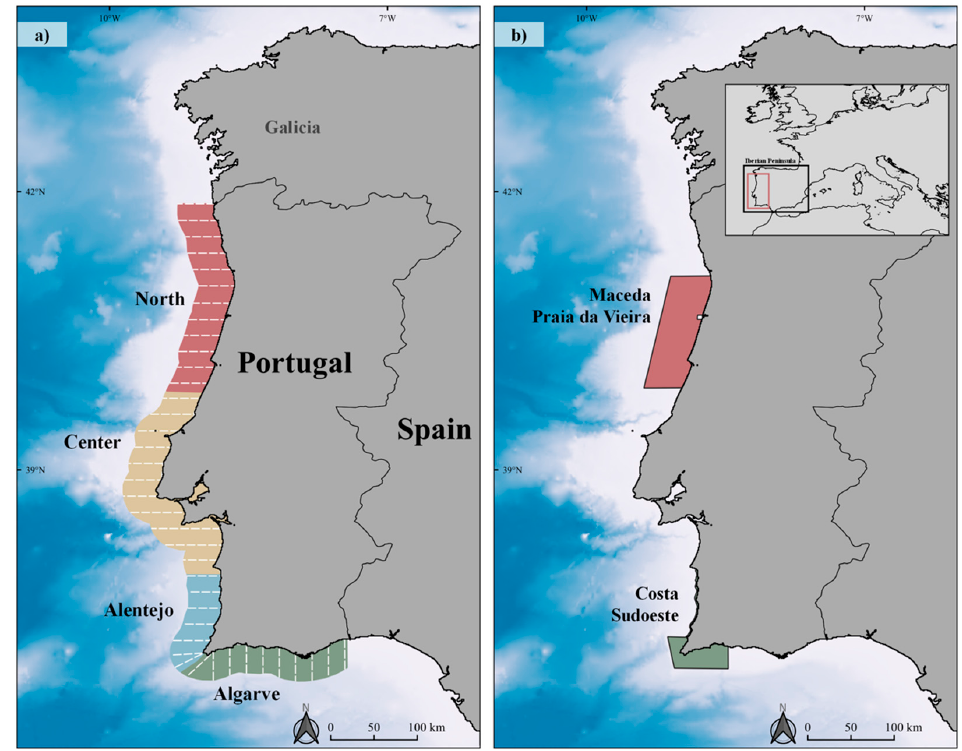
Figure 1. Study area in the continental coast of Portugal. ( a ) Overview of the survey area divided into four sectors: North, Centre, Alentejo, and Algarve; designed line transects (dashed white line); ( b ) Sites of Community Importance Maceda-Praia da Vieira (PTCON0063) and Costa Sudoeste (PTCON0012).